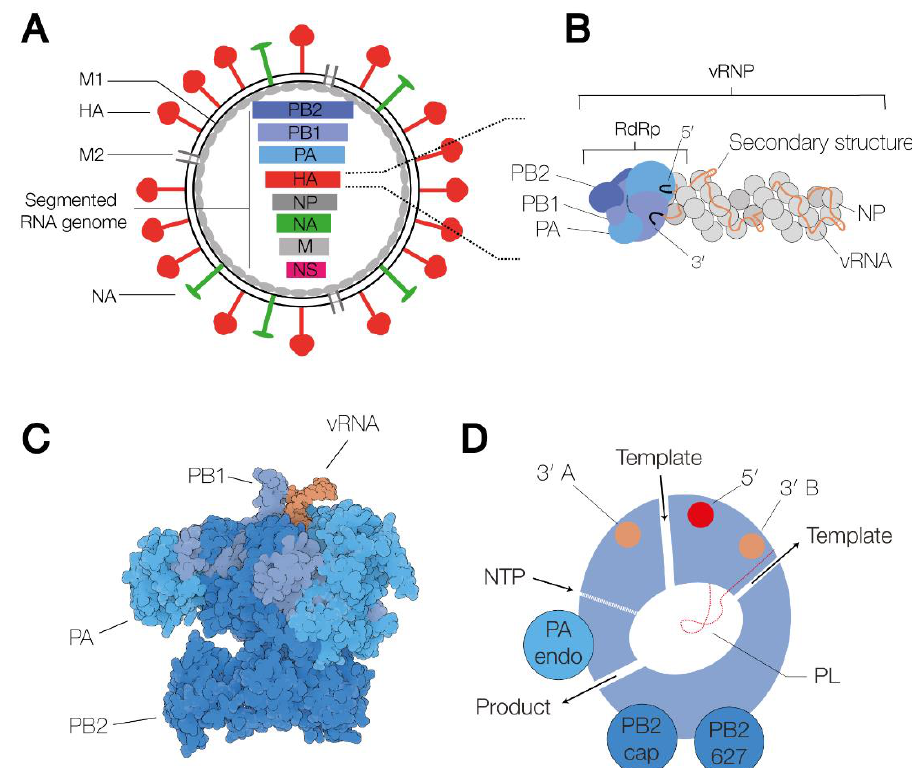
Figure 1. Schematic of the IAV virion, the viral ribonucleoprotein complex, and the viral RNA-dependent RNA polymerase. ( A ) Schematic of the IAV virion. The virion consists of a host cell-derived membrane, the surface glycoproteins HA and NA, the M2 ion channel, the M1 protein capsid, and the viral ribonucleoprotein (vRNP) complexes. The vRNPs each contain a segment of single-stranded, negative-sense viral RNA (vRNA). Eight of these vRNA segments make up the viral genome. ( B ) Schematic representation of a vRNP. The 5′ and 3′ termini of the vRNA (black) are bound by the heterotrimeric RdRp, which consists of the proteins polymerase basic 1 (PB1) (bright blue), PB2 (dark blue) and polymerase acidic (PA) (grey blue). The rest of the vRNA is associated with nucleoprotein (NP) monomers, forming an antiparallel double helix with a closing NP loop. ( C ) Surface model of the IAV RdRp in the transcription pre-initiation state (PDB 4WSB). The three polymerase subunits, PB1, PB2 and PA, are coloured bright blue, dark blue and grey blue, respectively. The 5′ and the 3′ end of the vRNA are coloured orange. ( D ) Schematic of the IAV RNA polymerase, in which the channels and RNA binding sites are indicated. The binding sites of the 5′ and the 3′ end are coloured red and orange, respectively.